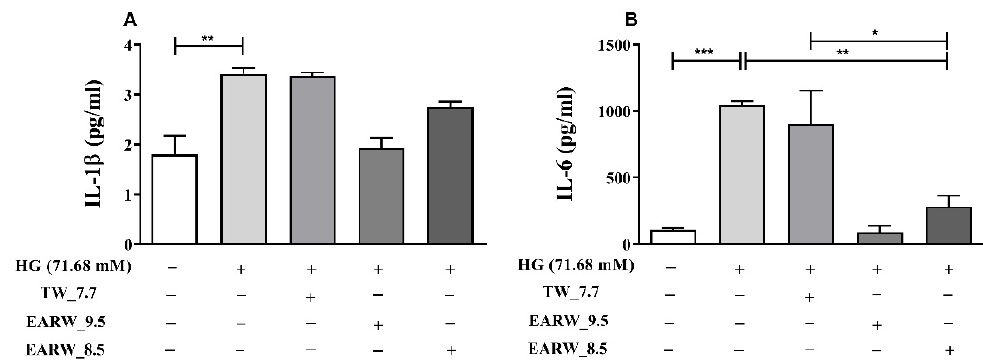
Figure 6. Pro-inflammatory cytokine markers IL-1 β and IL-6 were analyzed to investigate the effect of EARW_8.5 after HG-induction. Bio-Plex was used to perform and analyze the data for ( A ) IL-1 β and ( B ) IL-6 with or without the treatment of EARW_8.5. Values were calculated as mean ± SEM. * p < 0.05, ** p < 0.01 and *** p < 0.001 indicate significant differences tested with ANOVA.